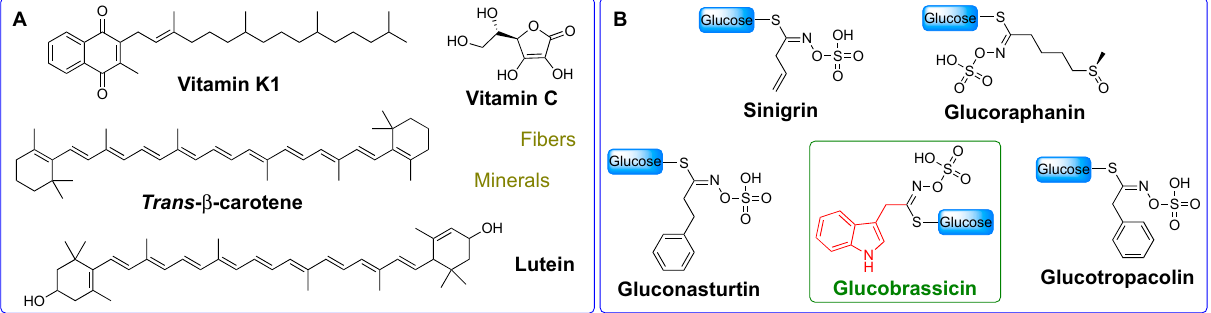
Figure 1. ( A ) Representative high nutritional value compounds contained in cruciferous vegetables. ( B ) The main bioactive glucosinolates found in cruciferous vegetables.